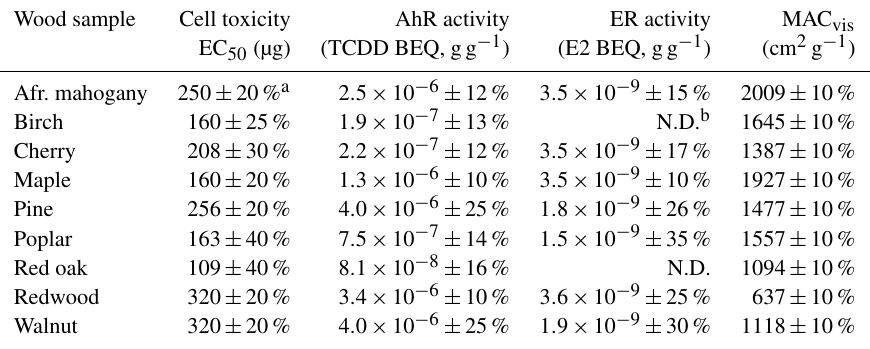
a Table values are reported as the mean of repeated trials with uncertainty noted as a percent of the mean that has been propagated from multiple sources. b Not detected (N.D.). Values are not significantly different than controls at this sample preparation